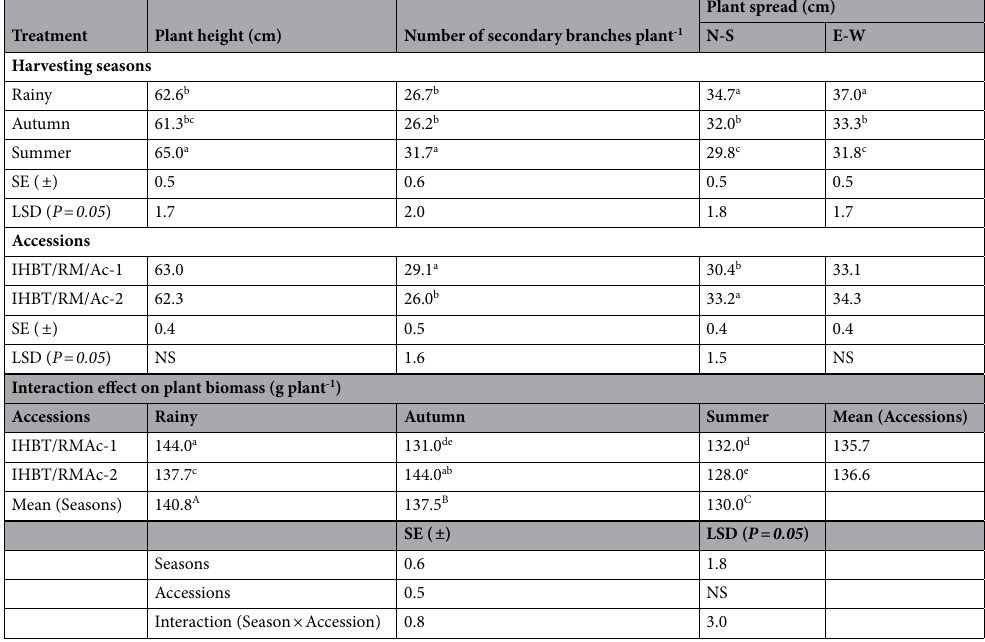
Table 1. Growth and biomass observations of R. officinalis accessions in different seasons of harvest and interaction of different seasons and accessions. Means with the same superscripted letter in the same column did not differ significantly ( P = 0.05); Interaction effect: similar superscripted letter indicate non significant differences and means without superscript letters do not differ